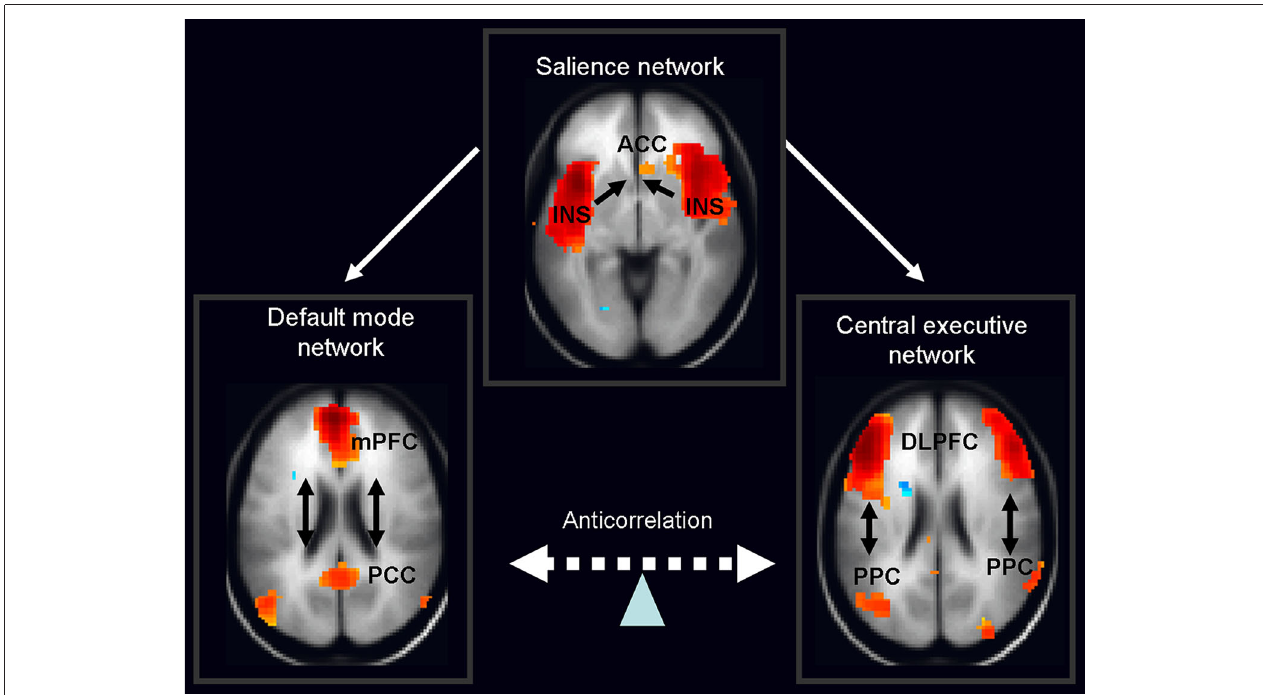
cortex, DPLFC: dorsolateral prefrontal cortex, PPC: posterior parietal cortex, mPFC: medial prefrontal cortex, PPC: posterior cingulate cortex, INS: anterior insula. Adapted from Menon and Uddin (2010); Sridharan et al. (2008), the images of networks derived from our in house resting fMRI sample, n =